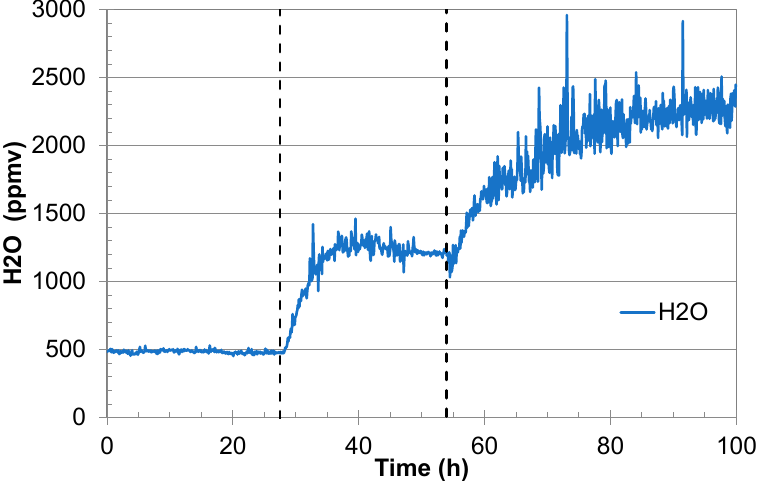
Figure 2. Water analysis from an experiment where the water injection was increased from 500 to 1250 ppmv (28 h) and from 1250 to 2200 ppmv (54 h).